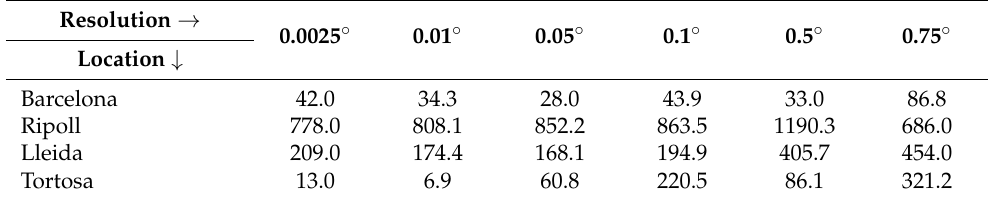
Table 1. Height of the pixel corresponding to the center of the cities marked (red dots) in panel A of Figure 3, according to the different resolutions of the pixels indicated in the same figure.